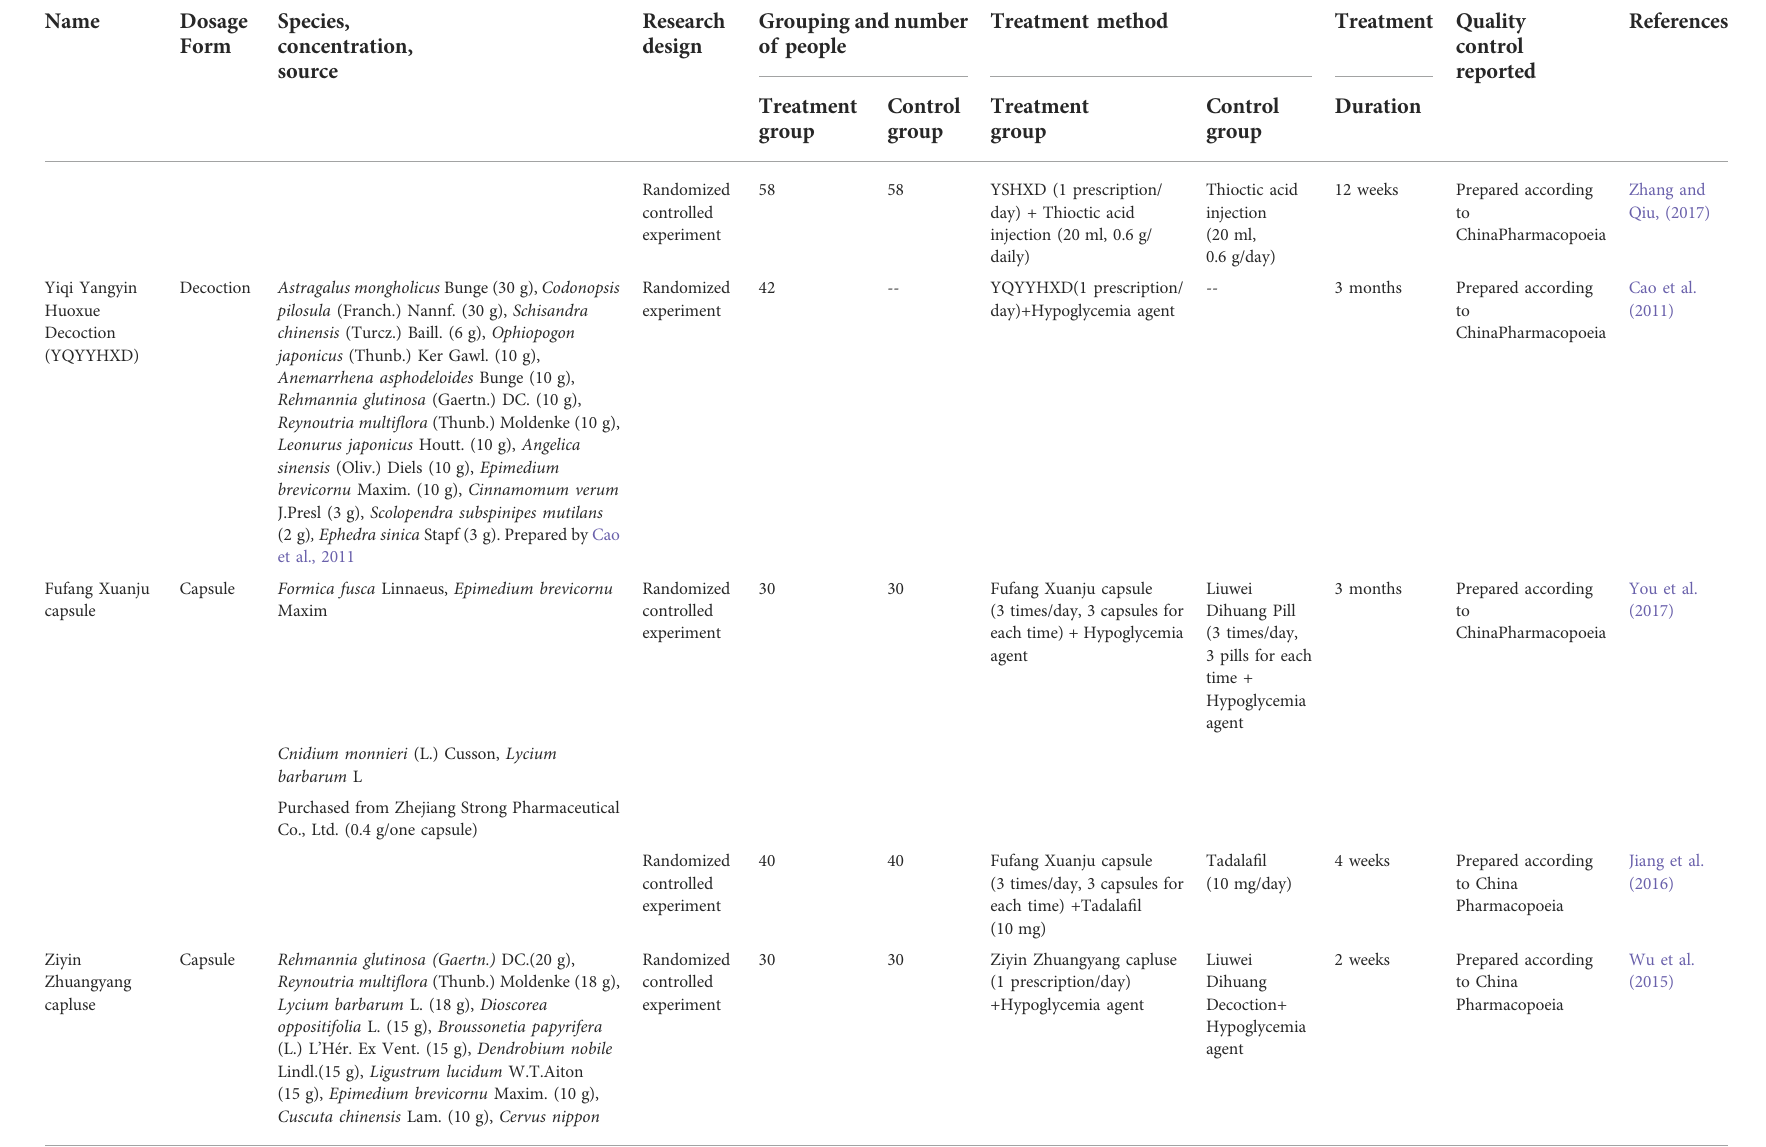
TABLE 1 ( Continued ) Summary of the prescribed formulae and natural products from Traditional Chinese medicine used in clinical